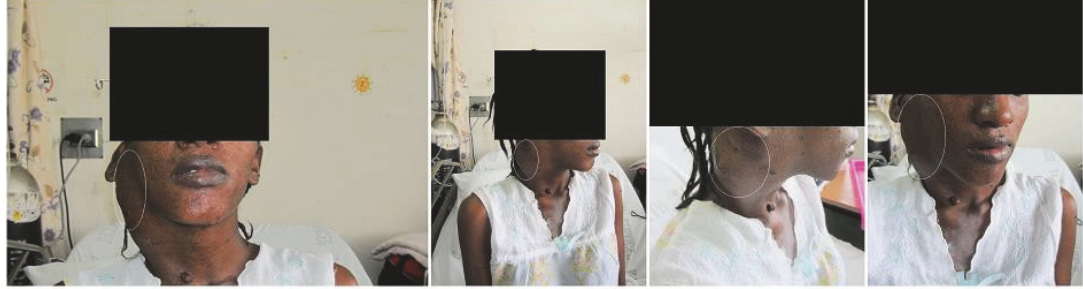
Figure 1: Facial depiction of the hematoma. Frontal series of the right neck hematoma (eclipsed in white), resulting from dissection of the right external carotid pseudoaneurysm.